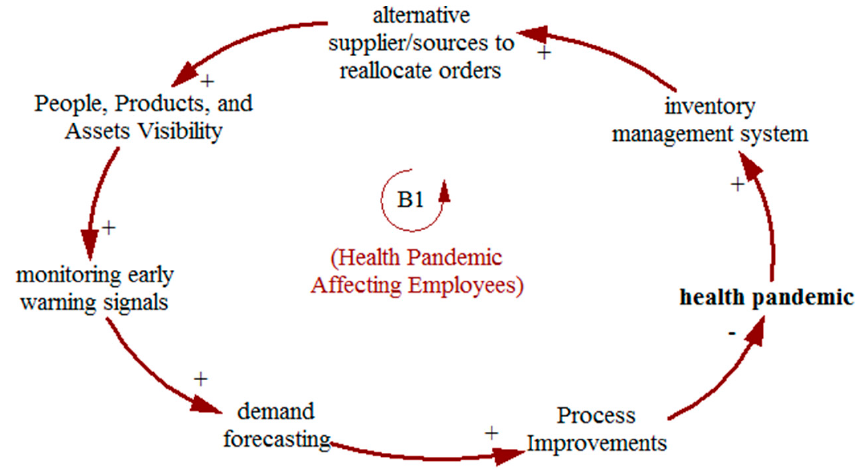
Figure 4. Balancing loop B1 (health pandemic affecting employees).